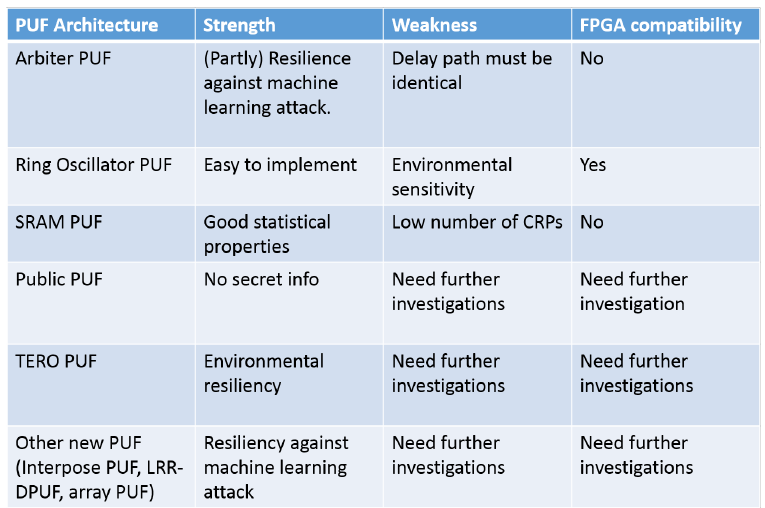
Figure 3. PUF architecture summary table. CRP, Challenge Response Pair; TERO, Transient Effect Ring Oscillator; LRR-DPUF, learning resilient and reliable digital